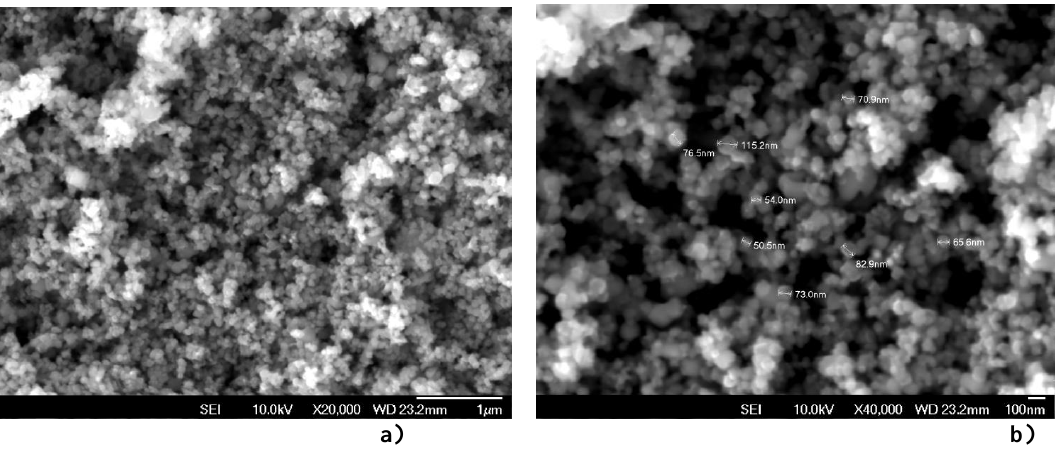
Fig. 5. SEM-images of the Top Raw View of the Nanoscaled Detonation Coatings of SiC on the Specimens of Steel 45 for Rolling-Sliding Friction: a) 20 000 zoom; b) 40 000